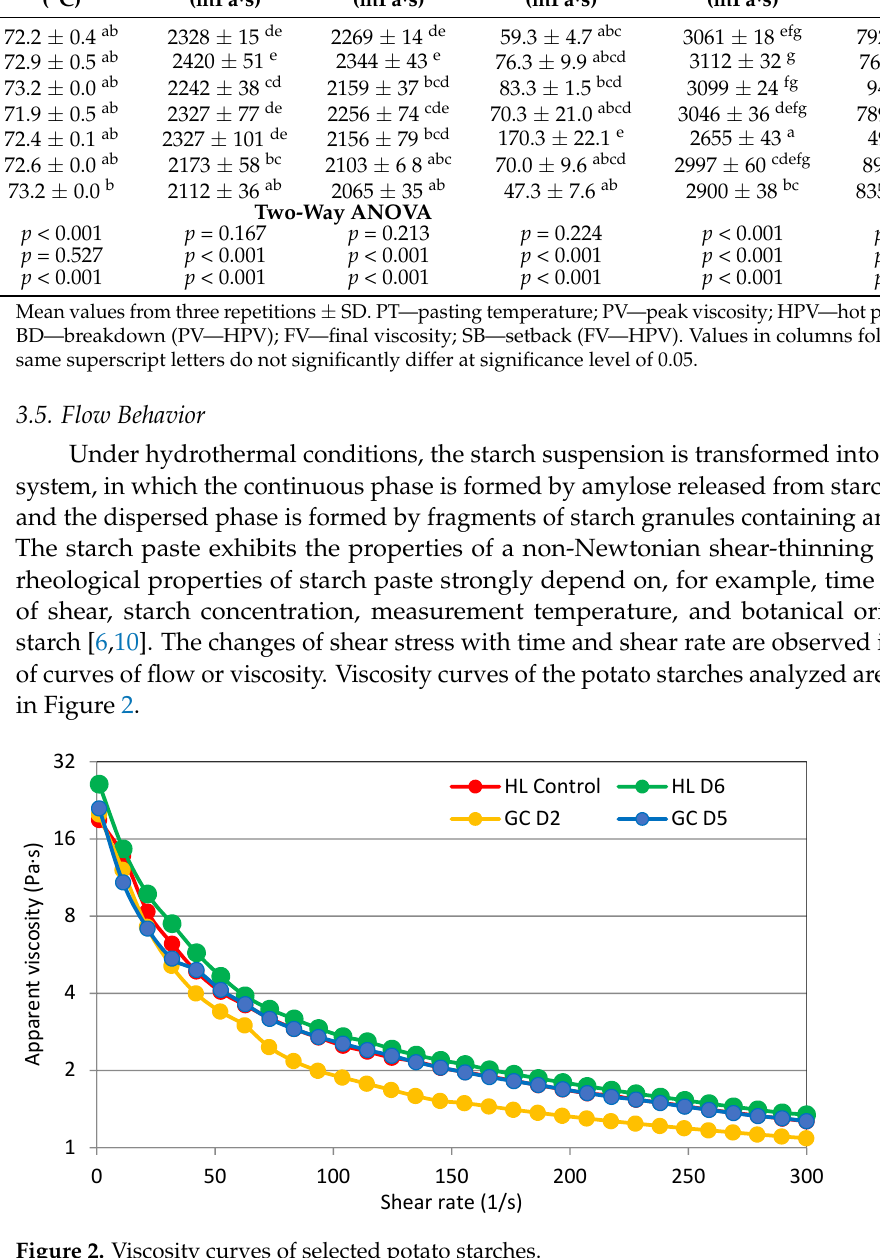
Figure 2. Viscosity curves of selected potato starches.